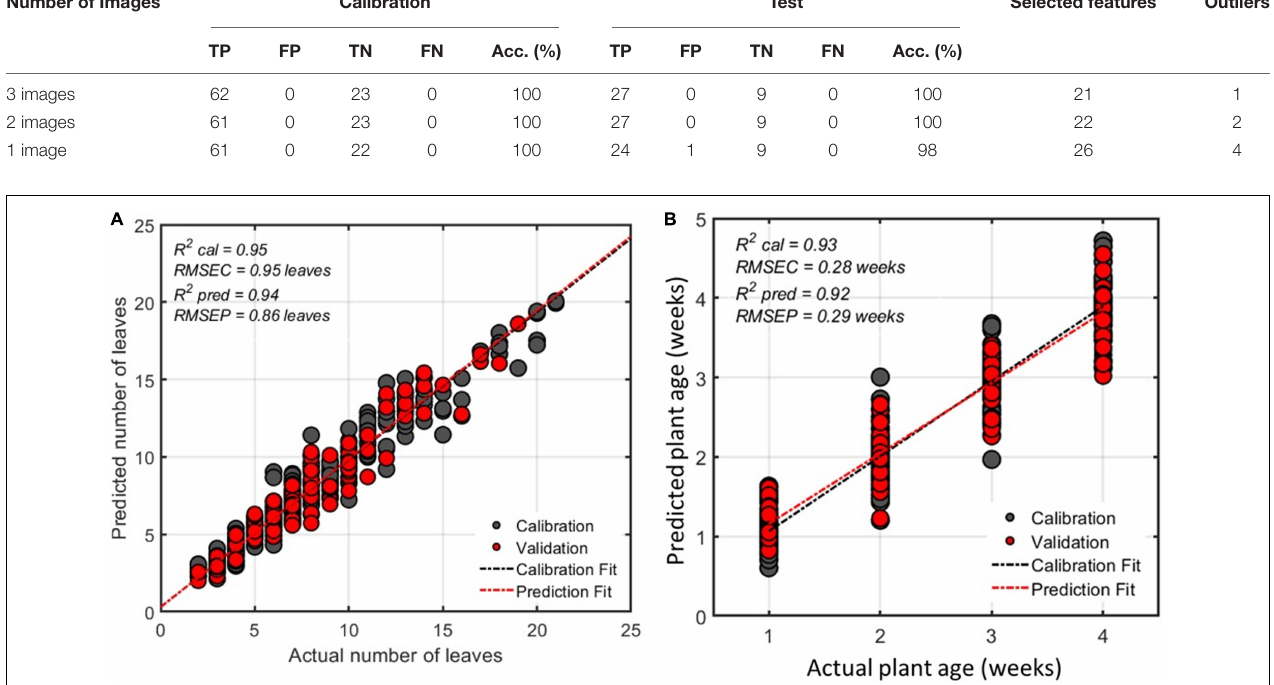
TABLE 6 | Comparison of classification results for normal and stressed watermelon plants using features from three-view, two-view, and one-view images. Number of Images Calibration Test Selected features Outliers